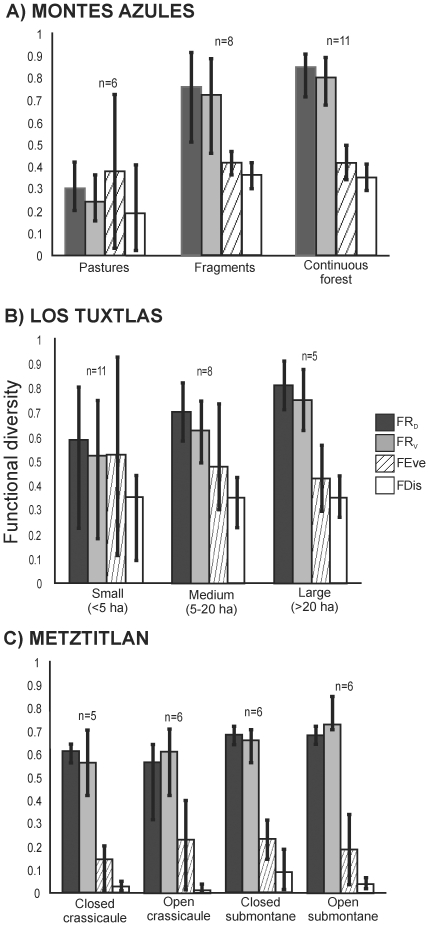
Mean values of functional diversity for the dung beetle communities
under different habitat conditions.(A) Montes Azules, (B) Los Tuxtlas and (C) Barranca de Metztitlán.
Error bars are standard error. The value of FRD (functional
richness) is based on dendrogram length, FRV (funcional
richness) is a convex hull volume of functional space, FEve (functional
evenness) is the regularity with wich the functional space is filled by
species, weighteg by their abundance, and FDis (functional dispersion)
is the mean distance of individual species to the centroid of all
species in the community.